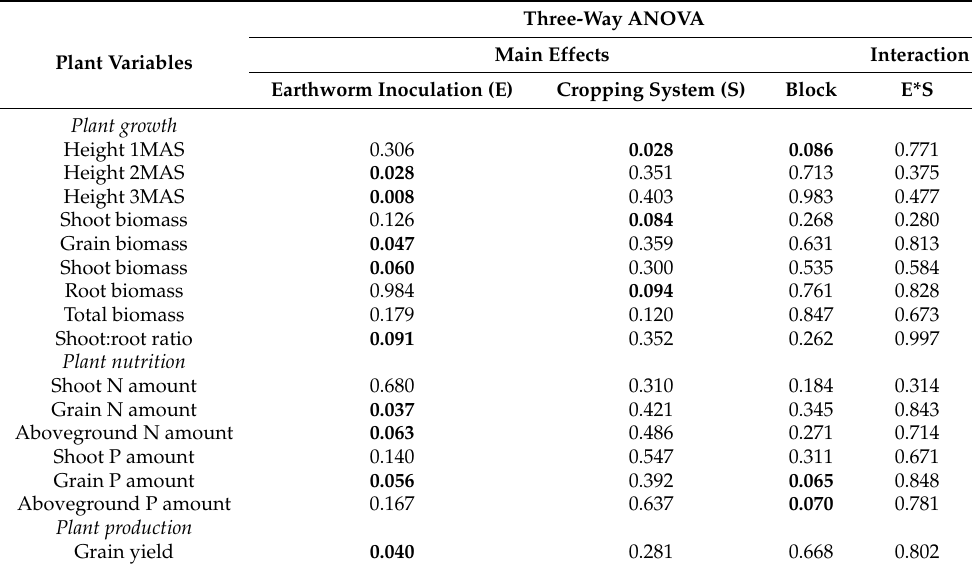
Table 6. ANOVA p -values of main effects (earthworm inoculation, cropping system, block) and their interaction on plant variables at the 3rd cropping season (2016–2017). E*S means the interaction between Earthworm inoculation (E) and Cropping system